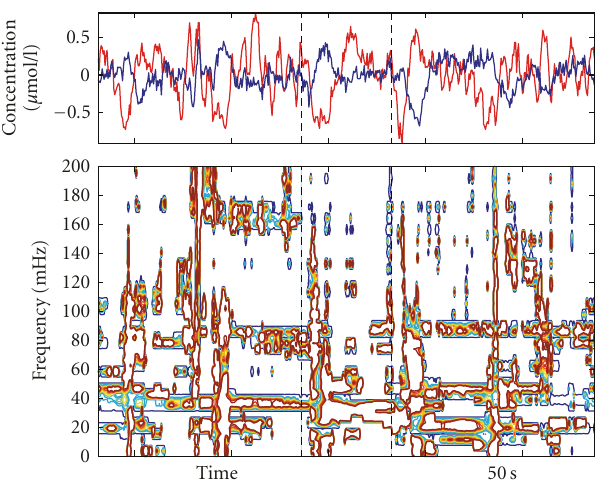
Figure 6: Time-frequency Squared Coherence Function (SCF) between the O 2 Hb (red line) and HHb (blue line) concentration signals during BH. The graph is relative to a subject su ff ering from migraine with aura. The vertical dashed lines mark the BH onset and o ff set. The SCF is represented by a contour plot. The white spots indicate time instants and frequency values where the coherence between the signals approximates